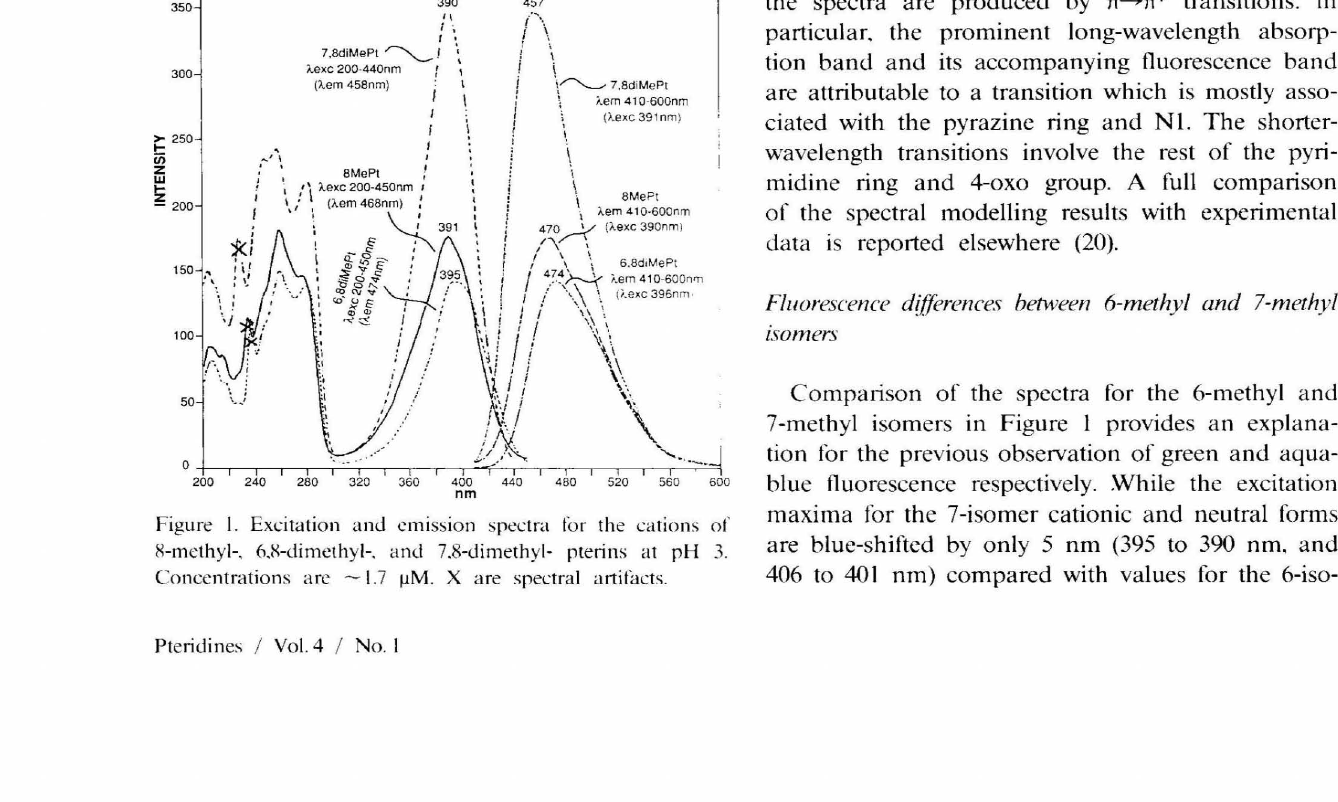
Figure I. Excitation and emIssIon spectra for the cations of H-mcthyl-. 6.H-dimcthyl-. and 7.8-dimethyl- pterins at pH 3. Concentrations are -1.7 I-lM. X are spectral artifacts. Pteridines / Vol.4 / No. I